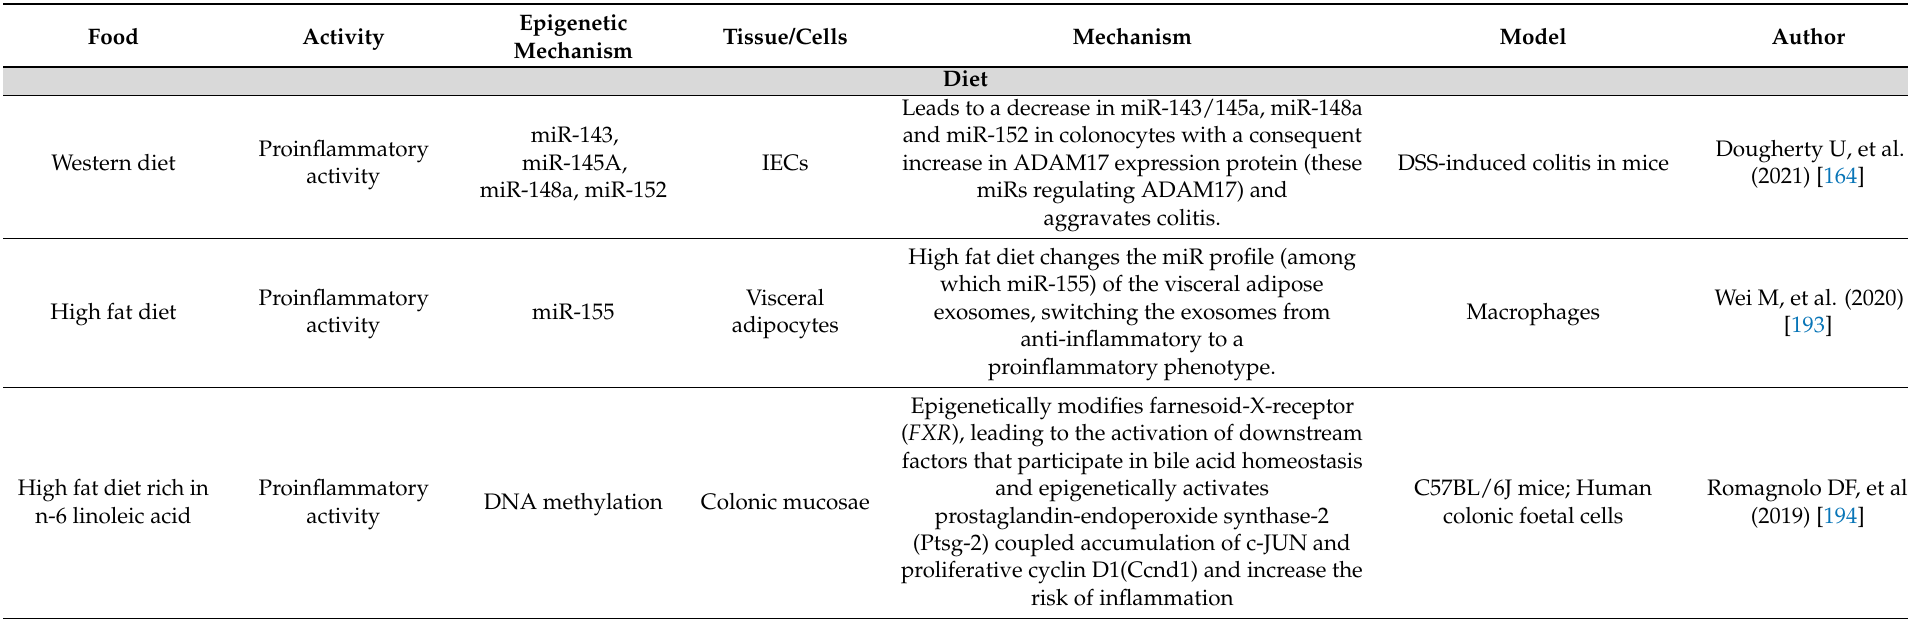
Table 3. Impact of the diet on the epigenome in intestinal inflammation . ADAM17, a disintegrin and metalloprotease-17; AIEC, Adherent-invasive Escherichia coli; CD, Crohn’s disease; CEACAM6, carcinoembryonic antigen-related cell adhesion molecule 6; CREB, C-AMP response element-binding protein; DNA, deoxyribonucleic acid; DNMT, DNA methyltransferase; DSS, dextran sulfate sodium; HDAC, histone deacetylase; HMGB1, high mobility group box 1; HRE, HIF-1-responsive elements; IBD, inflammatory bowel disease; ICAM, intercellular adhesion molecule; IEC, intestinal epithelial cell; IFN, interferon; IL, interleukin; lncRNA, long non-coding RNA; LPS, lipopolysaccharide; miR, microRNA; MMP9, Matrix Metallopeptidase 9; PBMC, peripheral blood mononuclear cell; PTEN, phosphatase and tensin homolog; NF- κ B, nuclear factor-kappa B; NLRP3, NOD-like receptor family pyrin domain containing 3; PECAM, Platelet endothelial cell adhesion molecule; RECK, reversion-inducing cysteine-rich protein with Kazal motifs; SCFAs, short-chain fatty acids; STAT, signal transducer and activator of transcription; TGF, transforming growth factor; TNBS, 2,4,6-trinitrobenzenesulfonic acid; TNF, tumor necrosis factor; UC, ulcerative colitis; VCAM, vascular